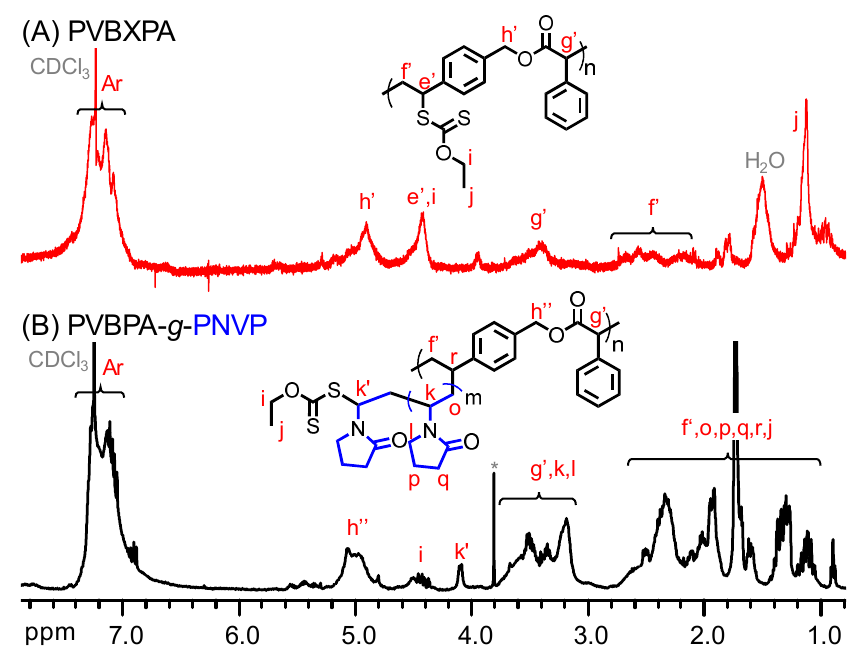
Figure 3. 1 H NMR spectra of ( A ) PVBXPA and ( B ) PVBPA- g -PNVP (co)polymers.